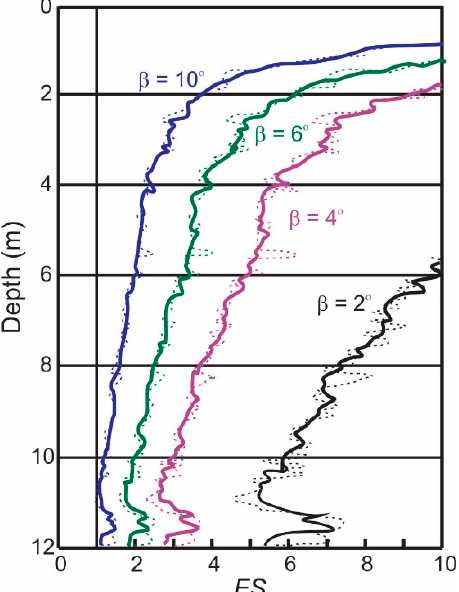
Figure 7. Plot of mean FS for various slope angles with depth for undrained conditions. The dashed lines are point averaged trends and the solid lines are averaged value trends.